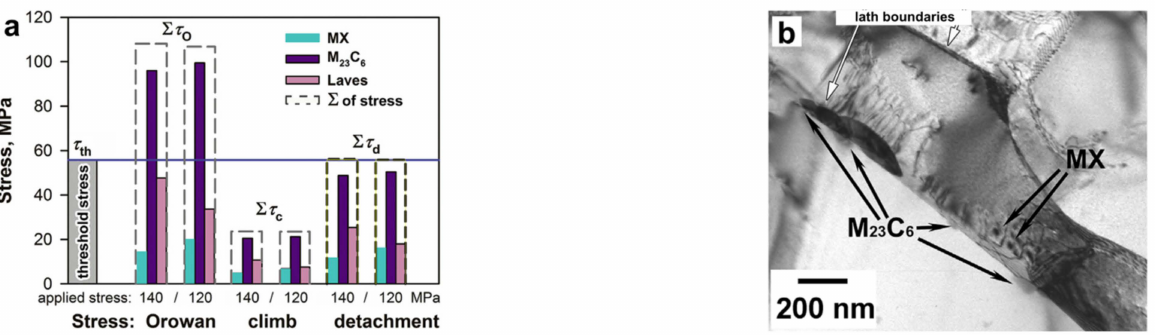
Figure 22. Chart diagram showing that the level of shear threshold stress (blue horizontal line) corresponds to the sum of detachment stress (in the right part), estimated for MX, M 23 C 6 , and Laves phase particles in the 10Cr steel at the apparent steady-state creep stage during short-term (140 MPa, 780 h) and long-term (120 MPa, 10,000 h) creep tests at 650 ◦ C ( a ). TEM micrograph showing interaction between fine M 23 C 6 and MX precipitates and dislocations in the 10Cr steel at the apparent steady-state creep stage at 650 ◦ C and 120 MPa, 10,000 h ( b ). Reprinted with permission from Ref. [8]. Copyright Elsevier 2019.